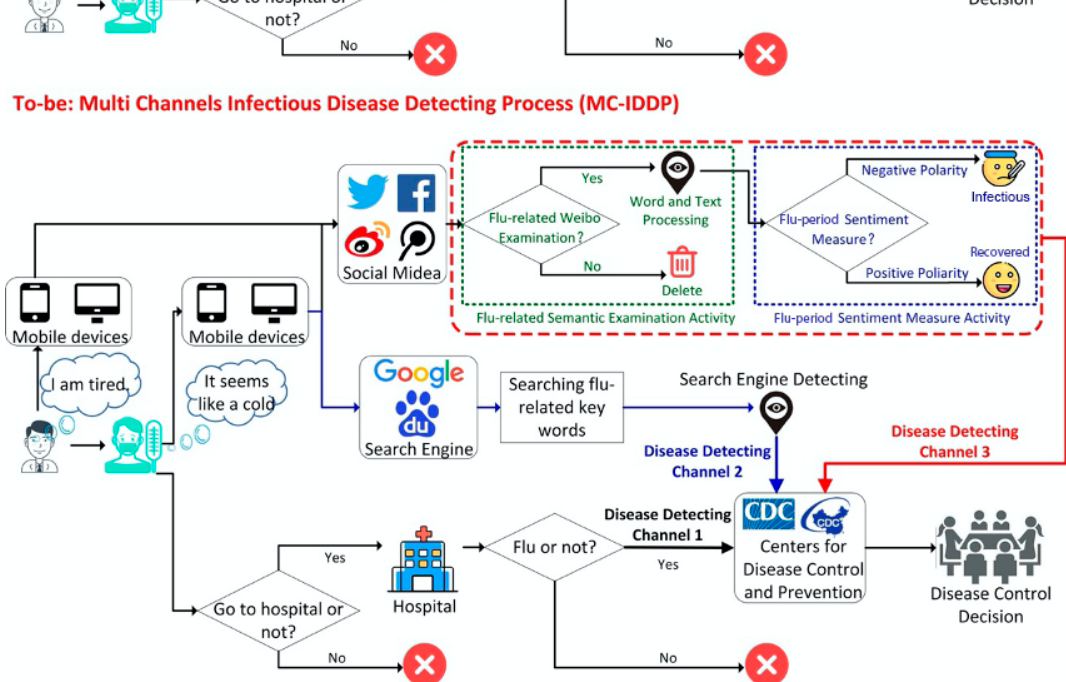
Figure 2. Solitary Channel and Multi-Channels Process.